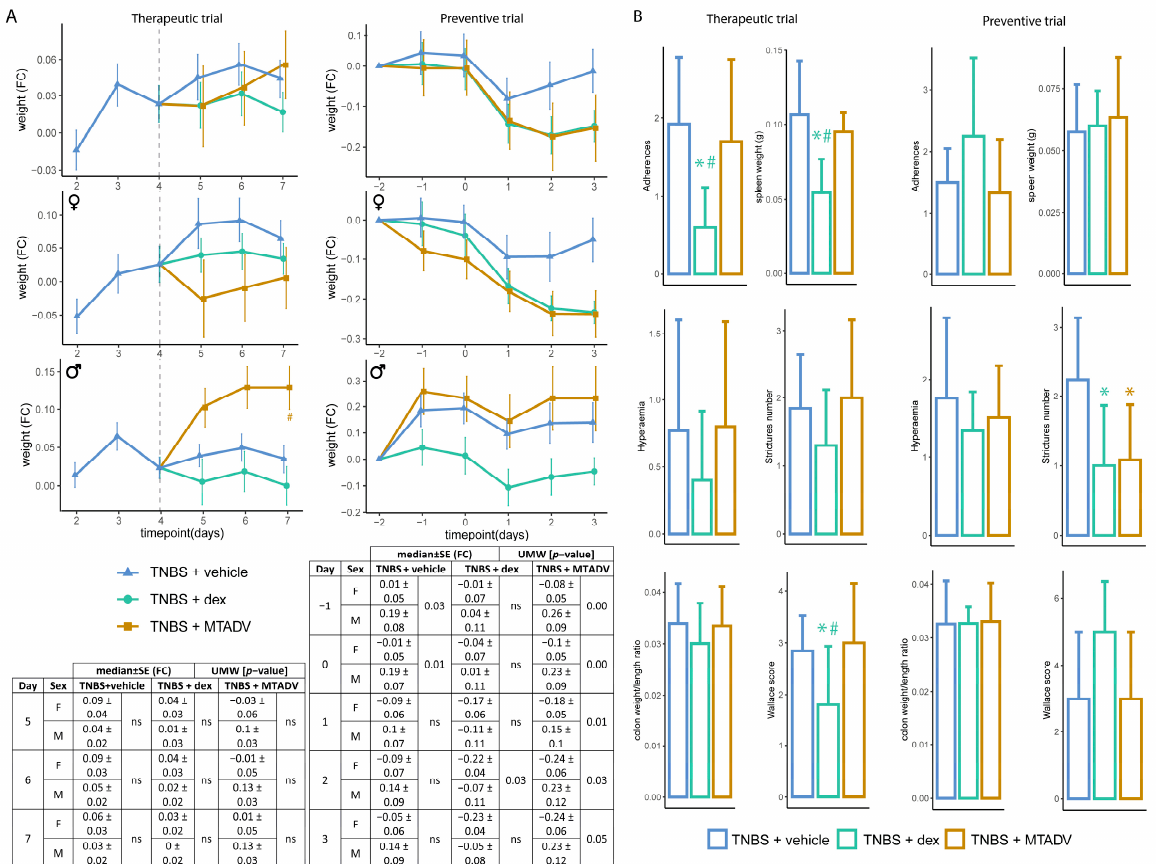
Figure 3. Macroscopic evaluations in the follow ‐ up of the TNBS model. ( A ) Body weight is repre ‐ sented as median FC ± SE in the follow ‐ up, represents therapeutic and preventive approaches, and is stratified by sex. Colors and dots denote treatment groups. Tables showing the statistical test (UMW) between sexes at each time point are given. ( B ) Morphometric data are represented for both therapeutic and preventive trials. Data are represented as bar plots (median ± SD). Each variable and metric are given on the Y ‐ axis, while colors indicate the treatment group. Asterisks indicate differences between treatments and vehicle administration, whereas pads mark differences between dexamethasone and MTADV treatments at each time point (Kruskal–Wallis with posthoc Dunn’s test). Significance levels: */ # 0.01 ≤ p ‐ value ≤ 0.05. BLI, bioluminescence intensity; dex, dexame ‐ thasone; F, female; FC, fold ‐ change; M, male; MTADV, 5 ‐ MER peptide methionine ‐ threonine ‐ ala ‐ nine ‐ aspartic acid ‐ valine; SD, standard deviation; SE, standard error; TNBS, trinitrobenzenesulfonic acid; UMW, U Mann–Whitney test.